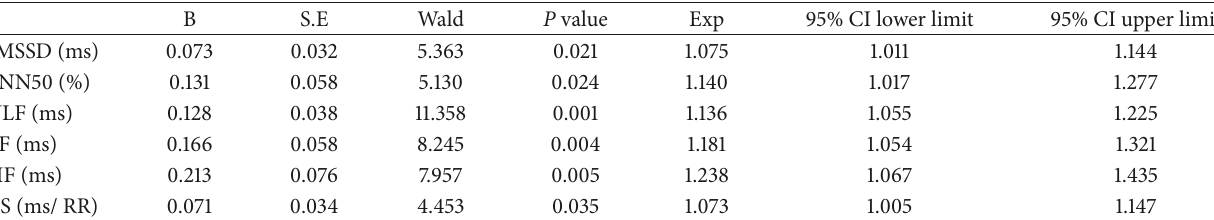
rMSSD,squarerootofmeanofthesumofsquaresofsuccessiveNNintervaldifferences;pNN50,numberofsuccessiveNNintervalsdifferingby >